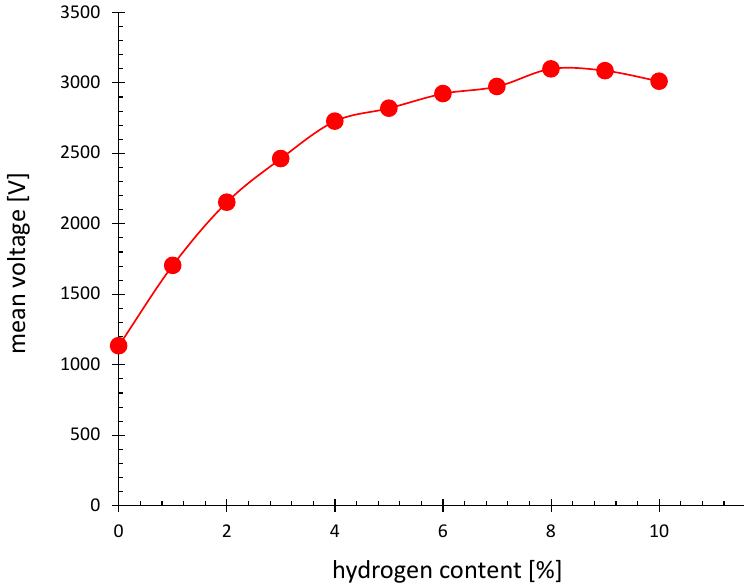
Figure 7. The mean voltage of the arc as a function of the percentage of hydrogen in the forming gas for an HV pulse frequency of 65 kHz and a total gas flow of 60